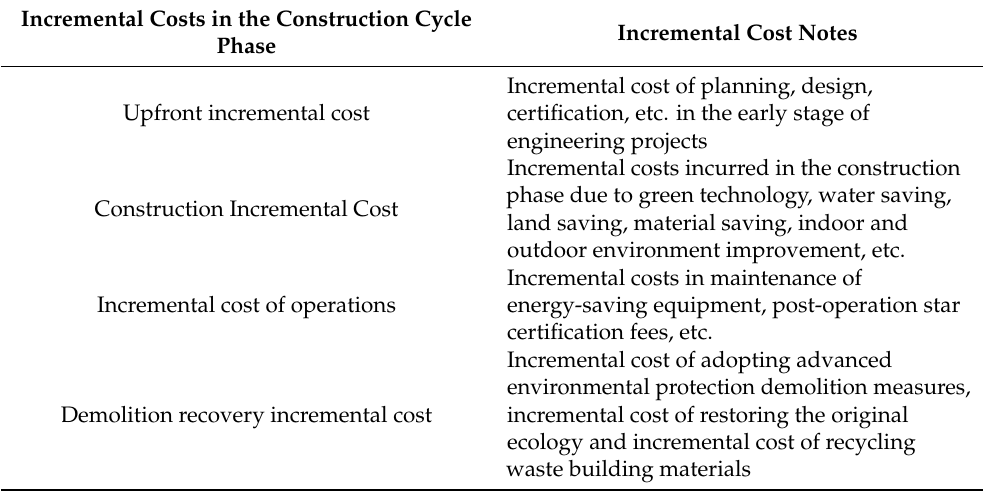
Table 1. Incremental Cost of Green Building.